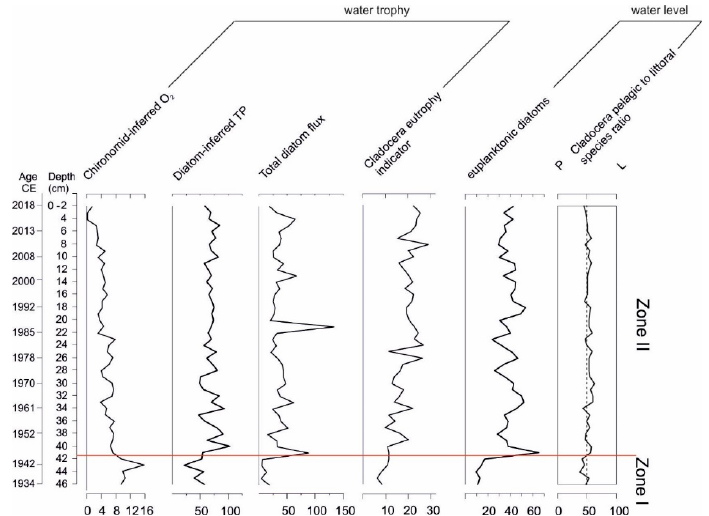
Figure 11. Comparison of indicators used to reconstruct trophic state changes: chironomid-inferred hypolimnetic oxygen reconstruction ( O 2 ) mg L − 1 , diatom-inferred total phosphorus reconstruction (TP) μ g L − 1 , total diatom flux (frustules × 10 6 /cm 2 /yr − 1 ), Cladocera based eutrophy indicators, and water-level changes indicators, such as the euplanktonic diatoms (%) and pelagic (P) to littoral (L) Cladocera species ratio (%).